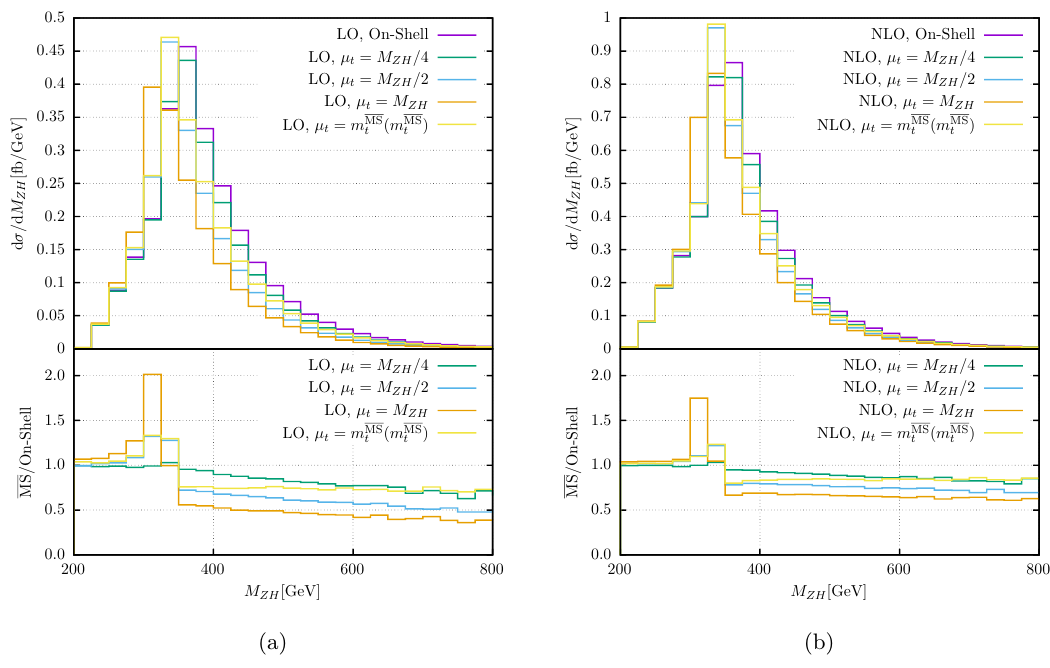
Figure 6. Invariant-mass distribution at LO (a) and NLO (b) for different choices of the top-mass renormalization scheme. The lower panels show the ratio of the MS results using various scales over the OS